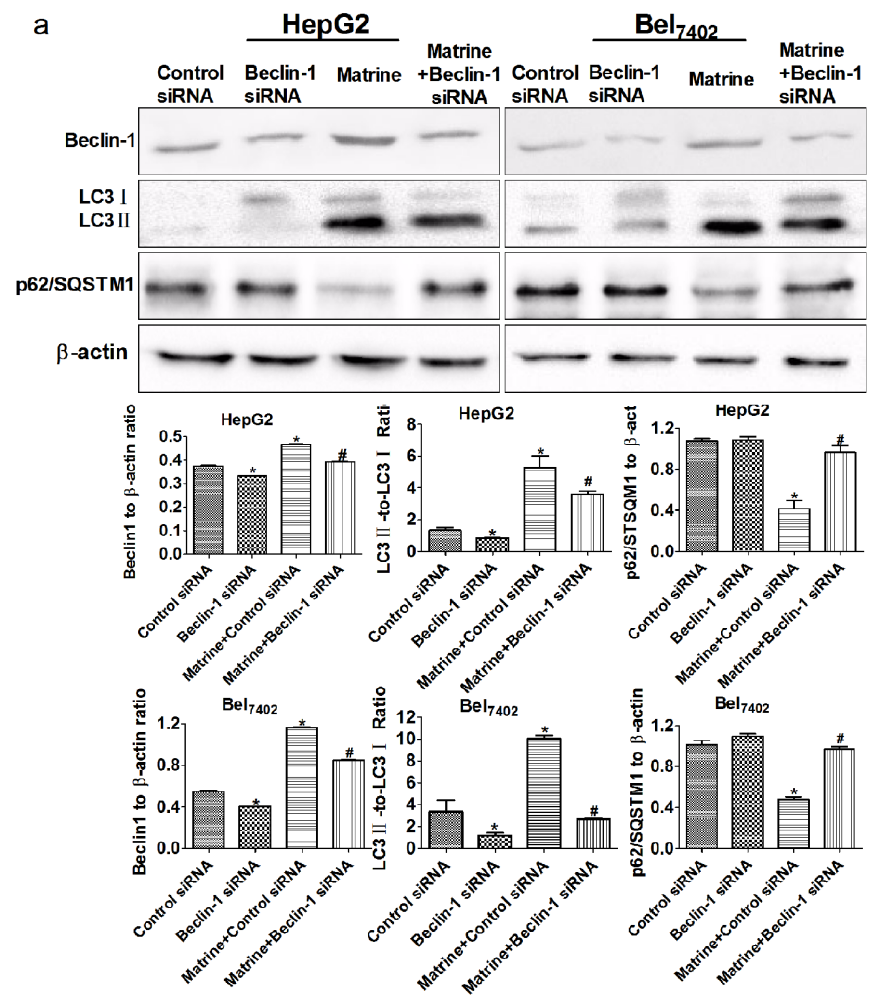
Figure 6. Effects of beclin-1 knockdown on matrine-induced autophagic flux and apoptosis in HepG2 and Bel cells. ( a ) Beclin-1 expression, the LC3BII/LC3BI ratio and 7402 p62/SQSTM1 in HepG2 and Bel cells after transfection with beclin-1 siRNA were 7402 detected by western blot. β -actin is shown as a loading control; ( b ) Representative confocal images of beclin-1-deficient cells after transfection with GFP-LC3 and treatment with matrine. LC3-positive autophagosomes in HCC cells were quantified using Image J (1.42q, NIH, Bethesda, MD, USA, 2009). Scale bars, 10 µm; ( c ) Apoptosis of HepG2 and Bel 7402 cells transfected with beclin-1 siRNA after treatment with matrine was detected by Annexin V-FITC and PI double-staining. Apoptotic cell death was analyzed by the total percentage of early and late apoptotic cells in different groups. Data are means ± SD of three independent experiments. * p < 0.05 vs . control group, # p < 0.05 vs . matrine